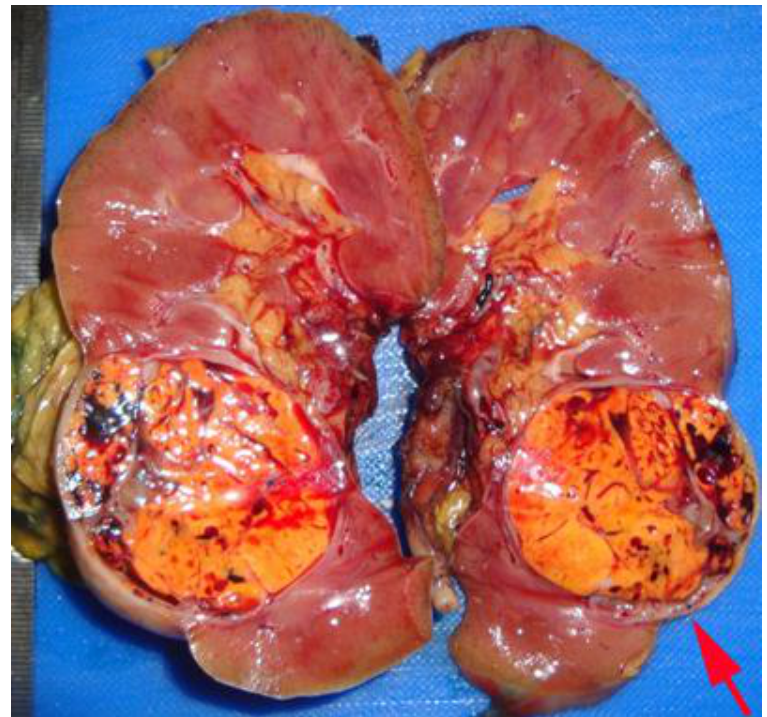
Figure 3A. If the outer surface of the tumor is smooth and convex, even if tumour protrudes well into the perinephric fat, it is not considered perinephric